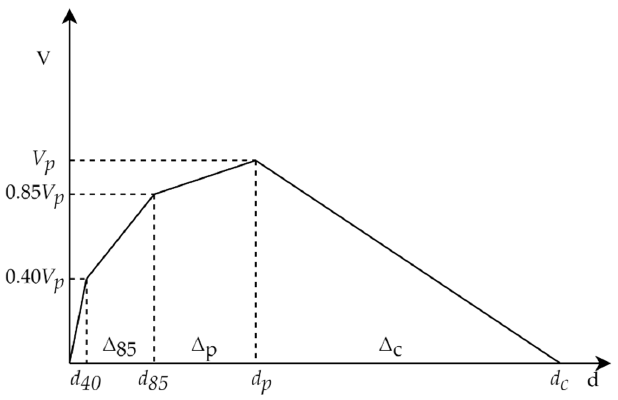
Figure 5. Pinching4 uniaxial material model [75].